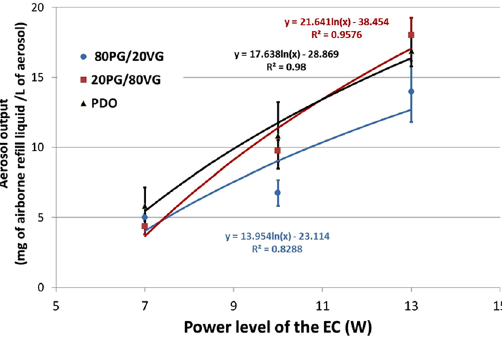
Figure 6. Impact of the power level of the EC on the aerosol output. Experiments